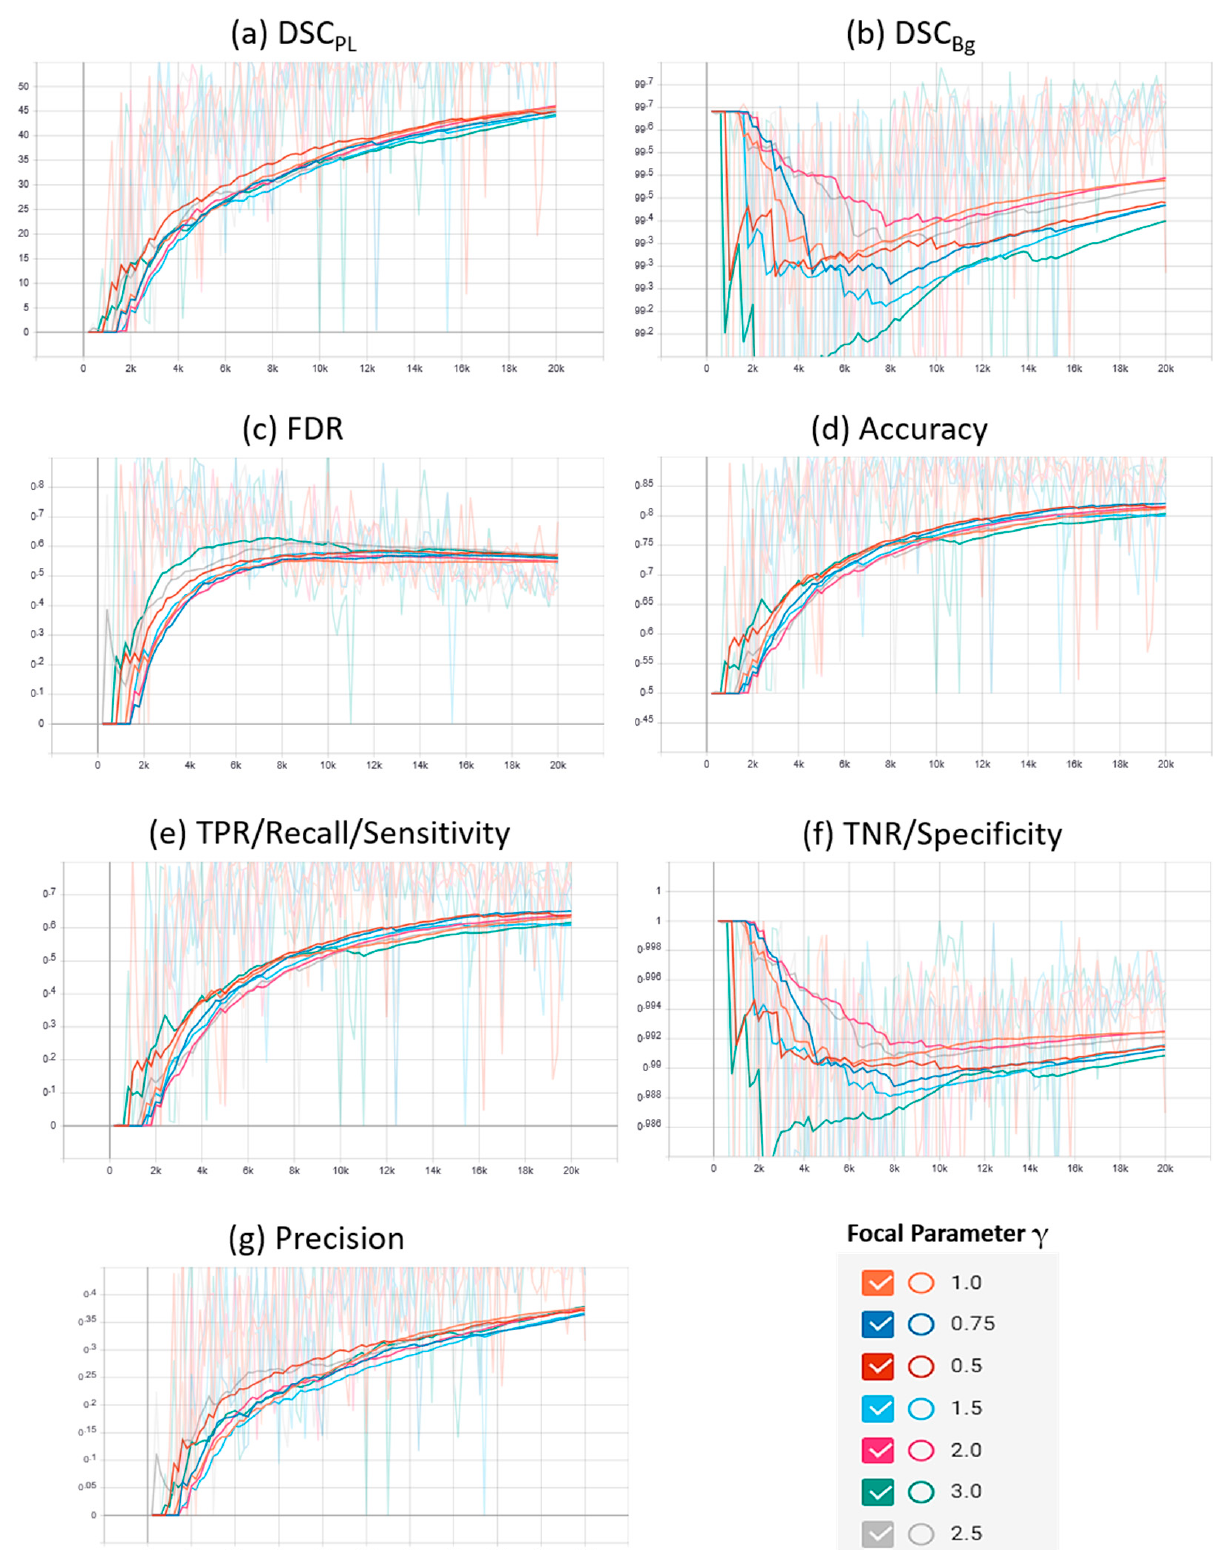
Figure 3. Characteristic evaluation parameters for the proposed focal Phi loss (FPL) function (with various values of focal parameter γ ) and the Matthews correlation coefficient (MCC) loss (with γ = 1.0) on the Mendeley PL dataset.